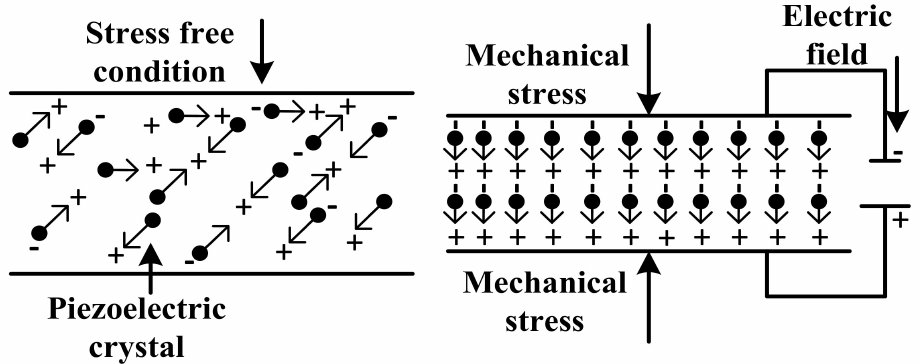
Figure 1. Piezoelectric materials producing an electrical charge with the application of mechanical stress. Cantilever beams are the most used structures for micro EH; the key feature of their design is to operate at the resonance frequency [7]. In these (unimorph/bimorph) struc- tures the dimensions are reduced, enabling the material to withstand higher stress